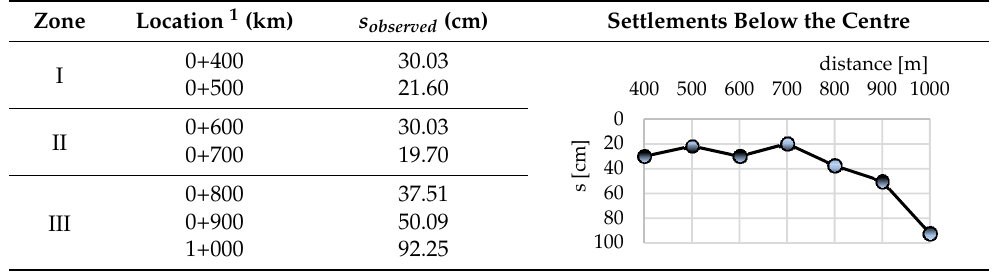
Table 3. Summary of the results of the observed settlements.